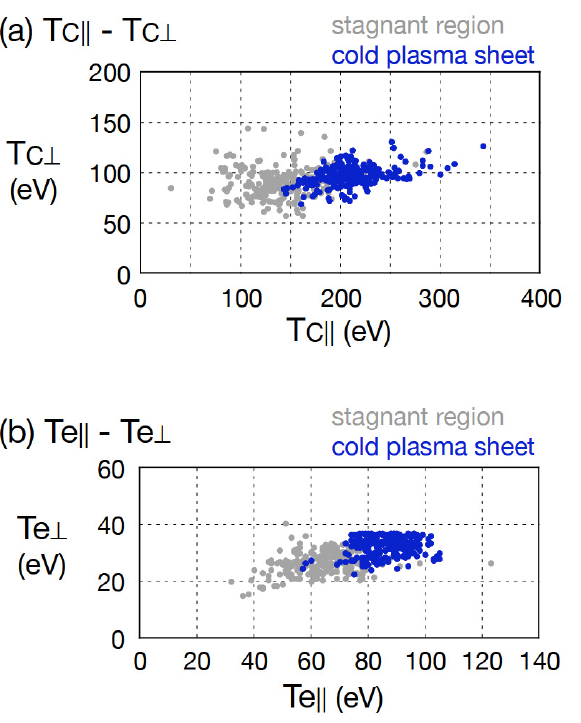
Fig. 11. Comparison between the temperatures in the stagnant re- gions of the interior interaction region and those in the cold plasma